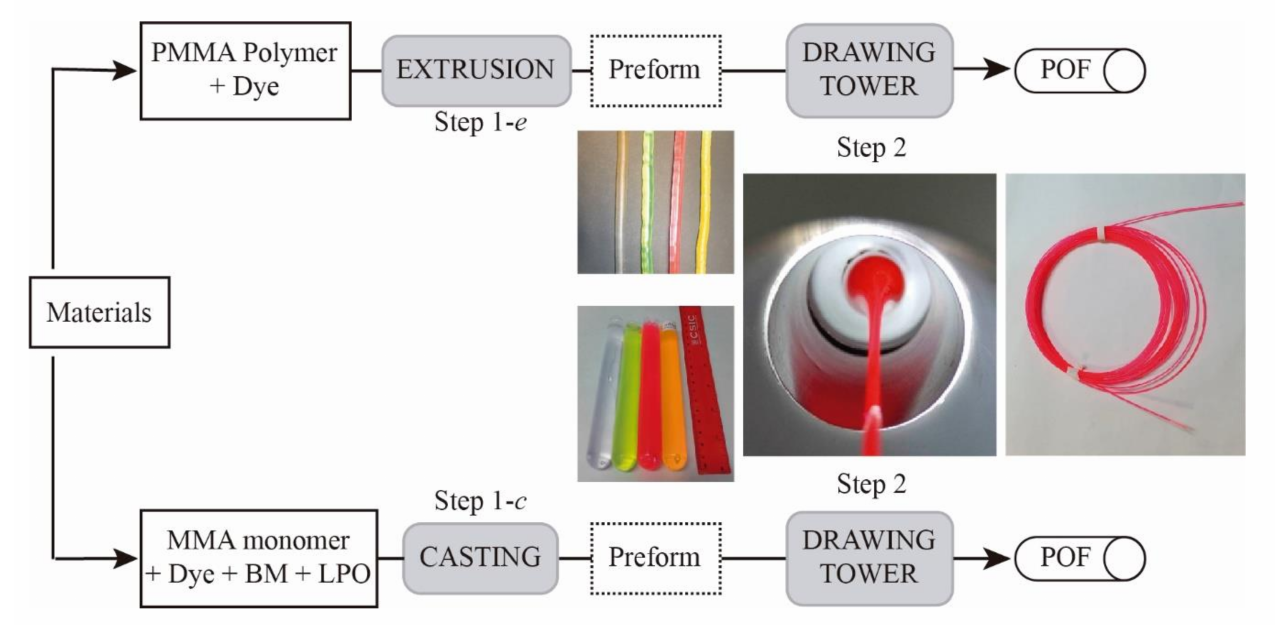
Figure 1. Schematic representation of the steps followed in each of the two processes for POF fabrication. Photographs of the extrusion (top) and casting (bottom) preforms, of a LR casting preform stretching in the drawing-tower and of the final LR casting